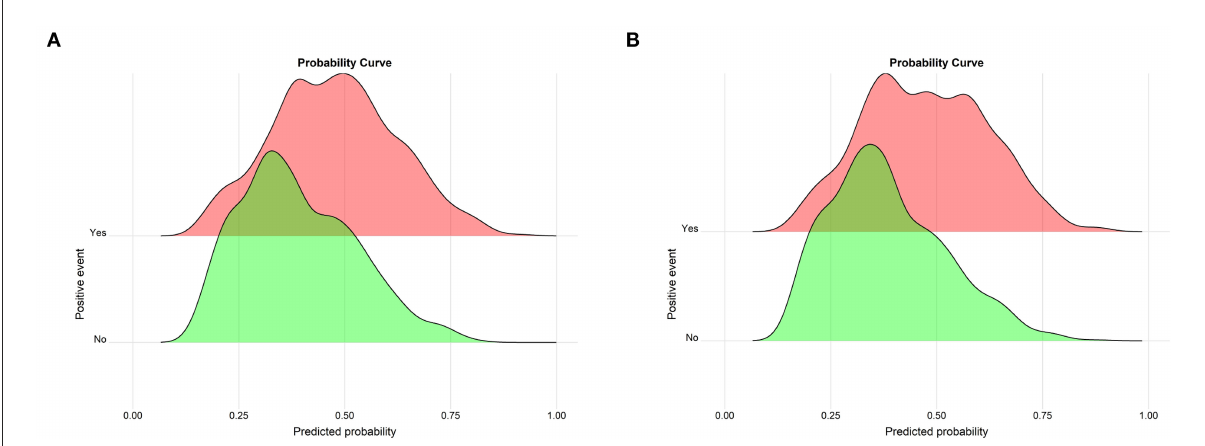
FIGURE6 Probability curve for the nomogram in the two groups. (A) The training group; (B) the validation group. Probability curve is drawn by predicted probability against events. The green curve indicates negative events (participants without medical disputes), whereas the red curve indicates positive events (participants with medical disputes). A greater distance between the peaks of the red and green curves on the nomogram implies better separation.